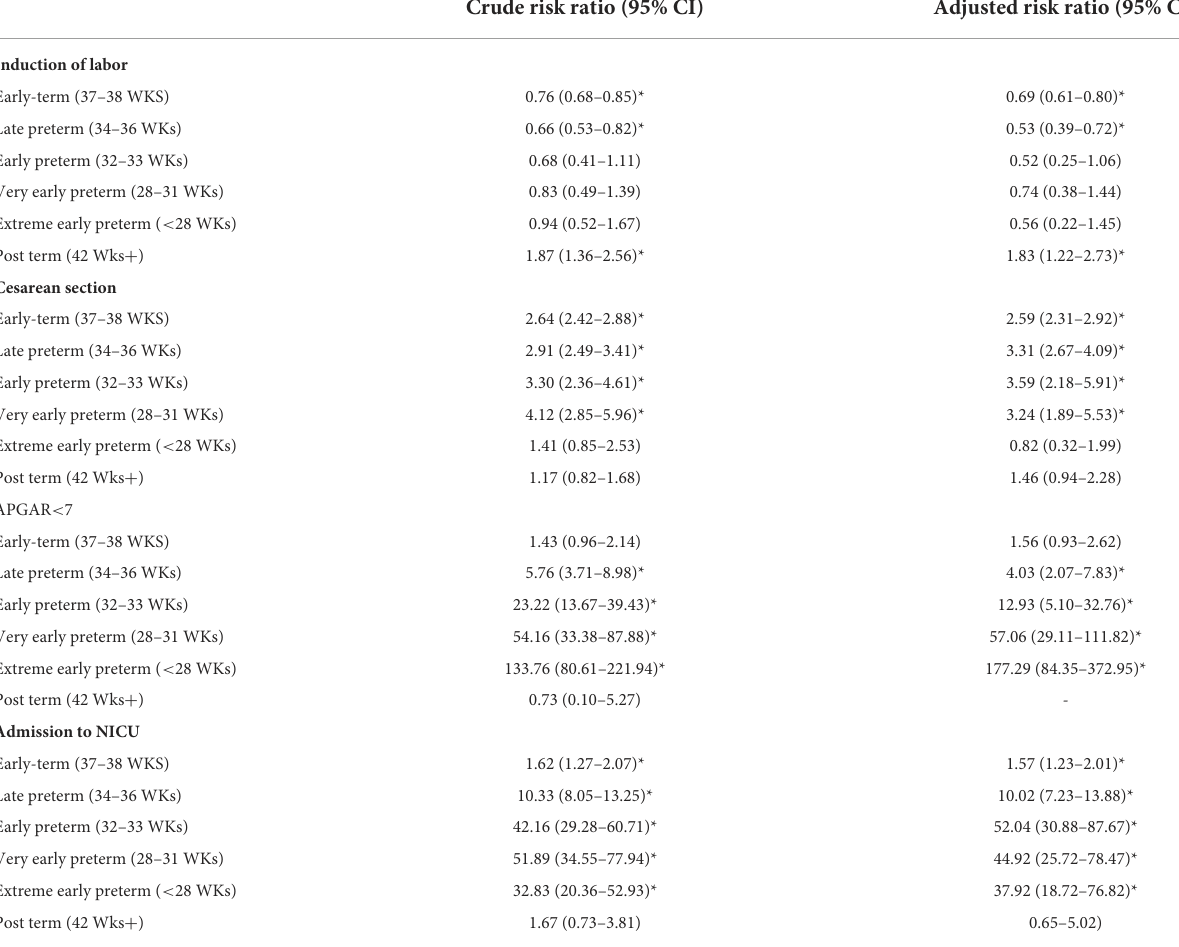
TABLE 3 Independent effect of gestational age at delivery on maternal and short-term neonatal outcomes. Crude risk ratio (95%